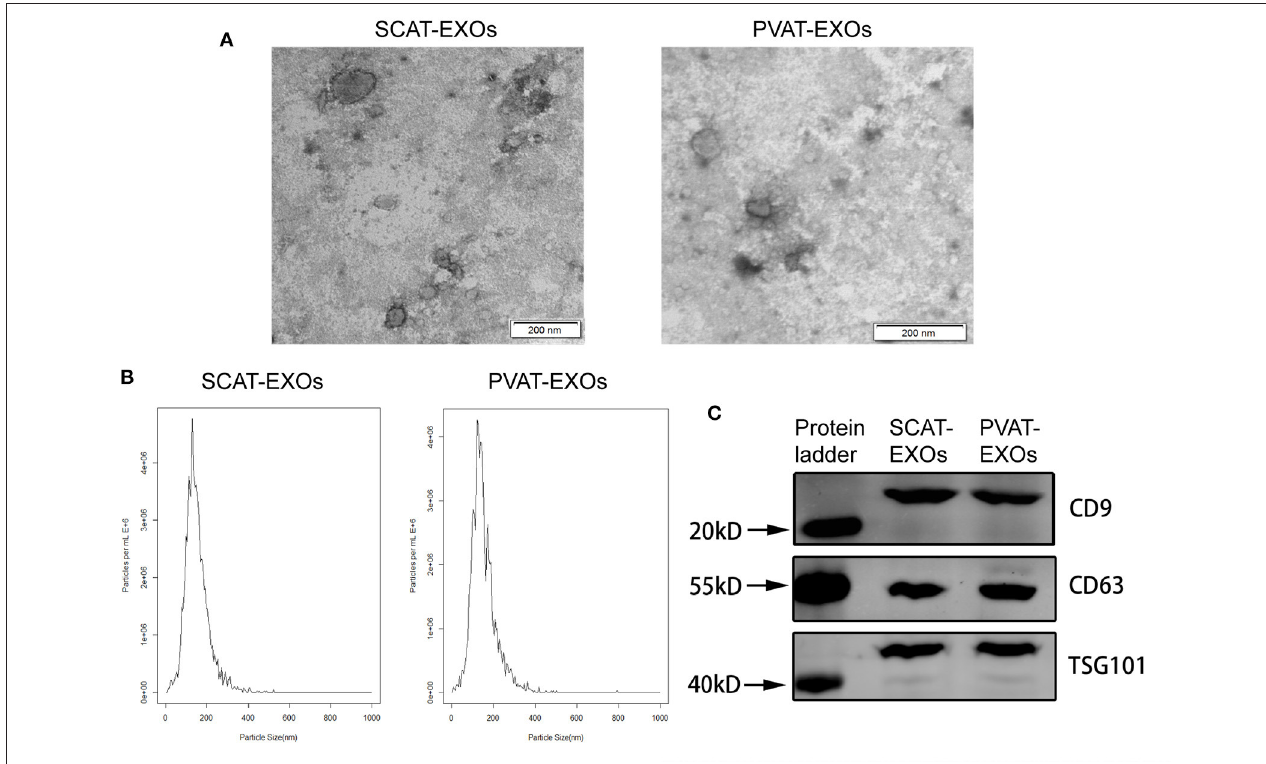
FIGURE 1 | Characterisation of SCAT-EXOs and PVAT-EXOs. Exosomes were identified by transmission electron microscopy (A) . Scale bars: 200nm. Nanoparticle tracking analysis showed the particle size distribution of exosomes (B) . The exosome-related protein markers CD9, CD63, and TSG101 were measured by Western blotting (C)